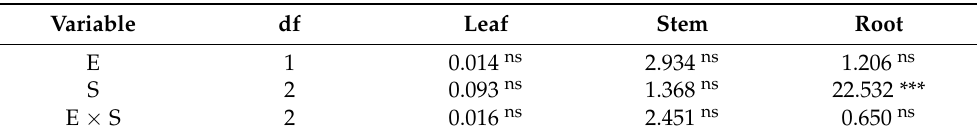
Table 7. Two-way ANOVA for the effects of endophyte (E) and CdCl 2 stress(S) on chemical forms of Cd in leaves, stems and roots of Hordeum brevisublatum . Variable df Leaf Stem Root E 1 0.014